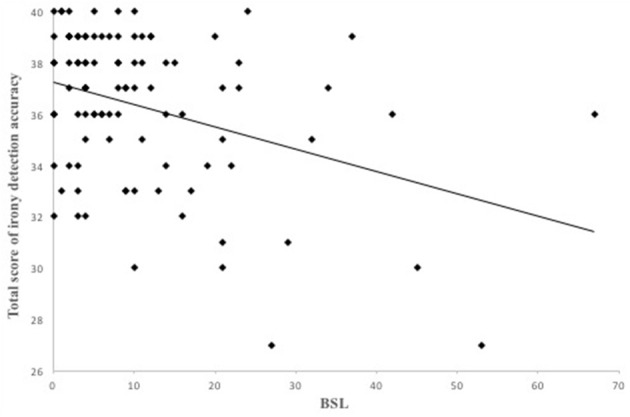
Borderline personality traits negatively predicted the total score of irony detection accuracy in tuerony in a linear regression.